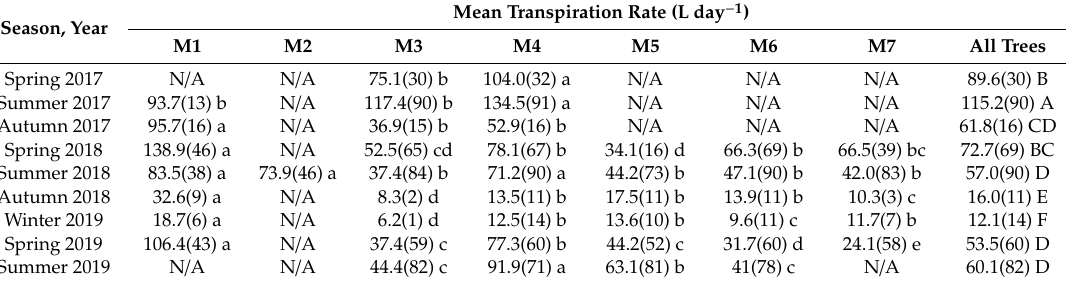
Table 5. Transpiration rates of mature juniper trees in the untreated Jensen WS, averaged by individual tree (M1–M7), and by all mature trees, for summer (1 July to 30 September), autumn (1 October to 31 December), winter (1 January to 31 March), and spring (1 April to 30 June), from May 2017 through September 2019. Di ff erent lowercase letters (a, b, c, d, e) along rows indicate significant di ff erences ( p ≤ 0.05) in mean transpiration rate by mature trees for each season. Di ff erent uppercase letters (A, B, C, D, E, F) along the last column indicate mean di ff erences ( p ≤ 0.05) by season for all trees. Numbers in parentheses for M1–M7 represent the number of days when sap flow data were collected for each individual tree. Numbers in parentheses for all trees represent the number of averaged days. N / A = Data not